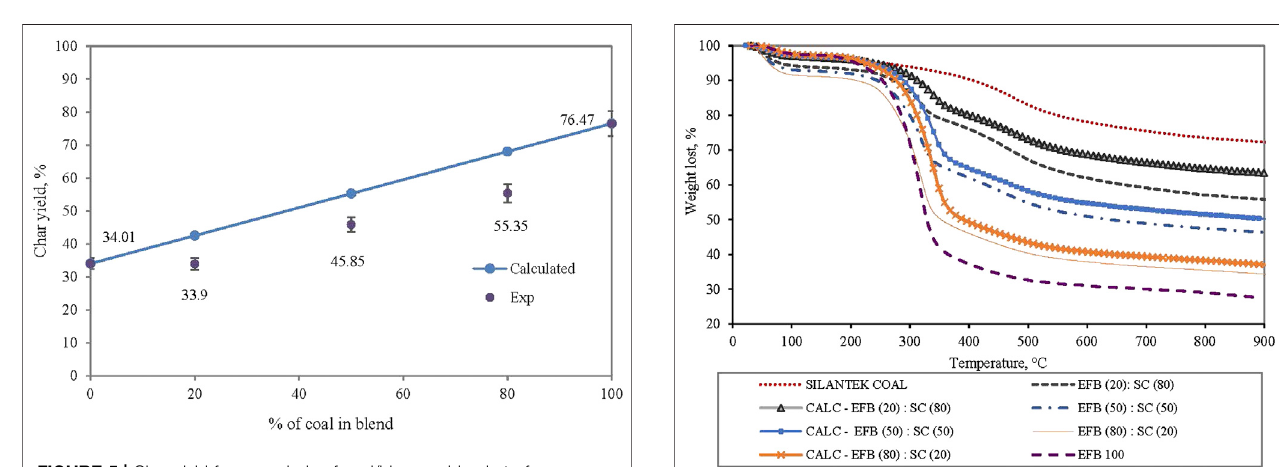
Frontiers in Energy Research |